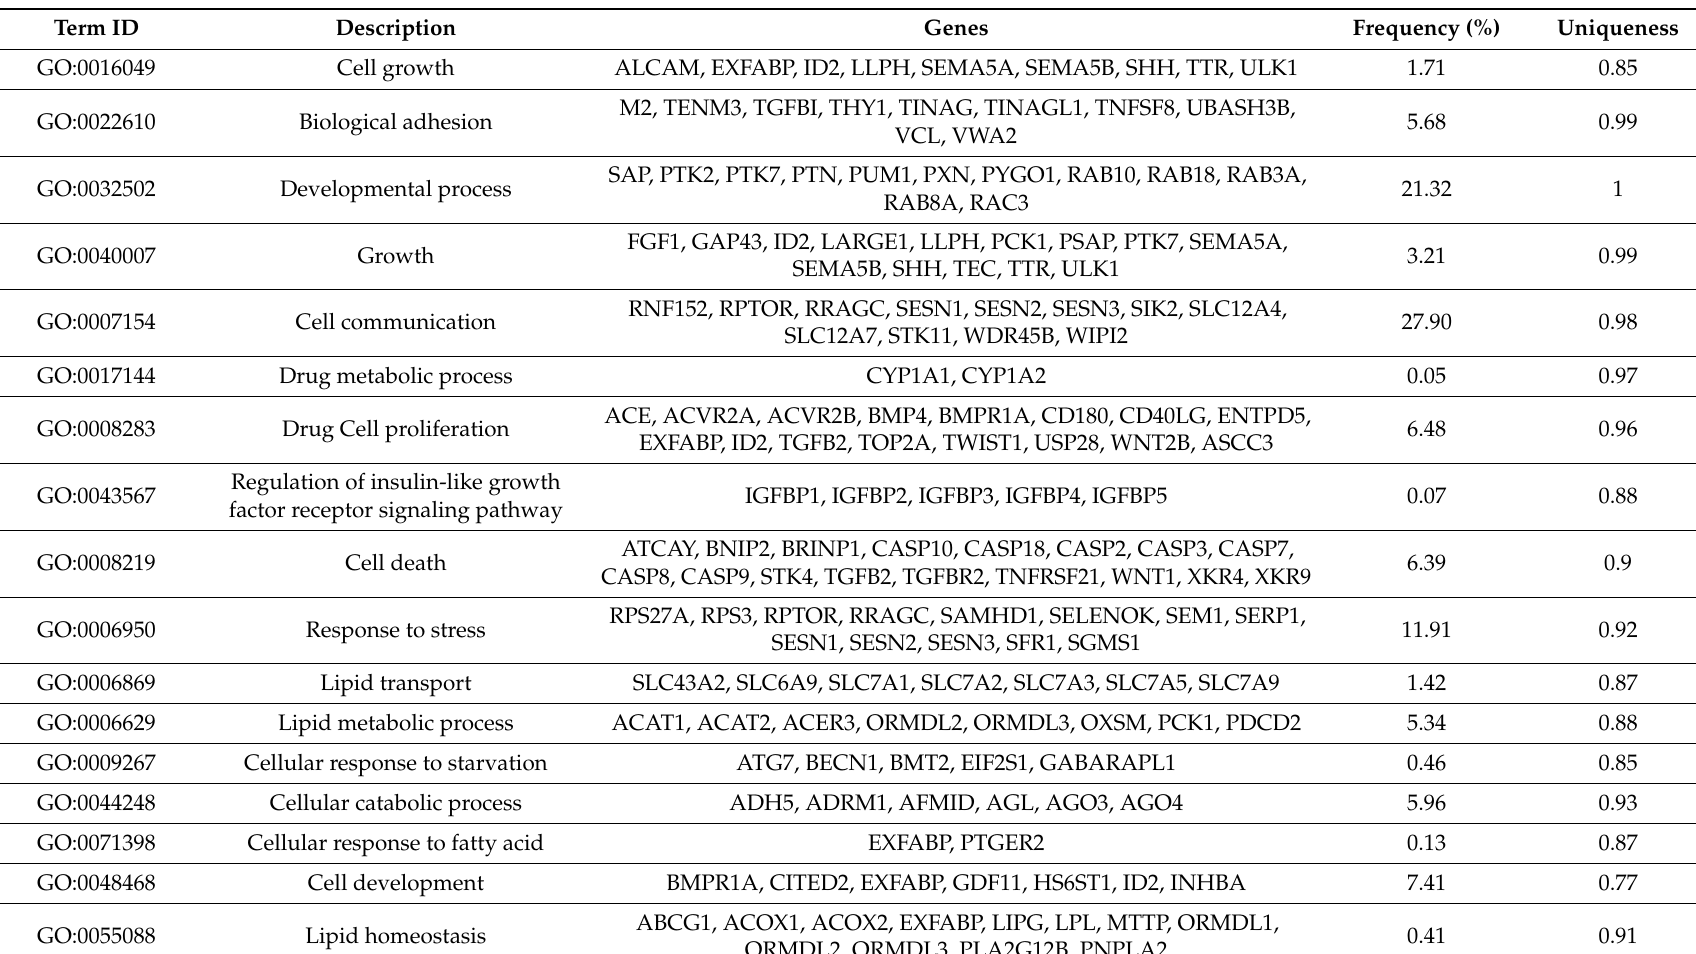
Table 3. Significantly enriched biological processes involved in cell growth, development and lysine